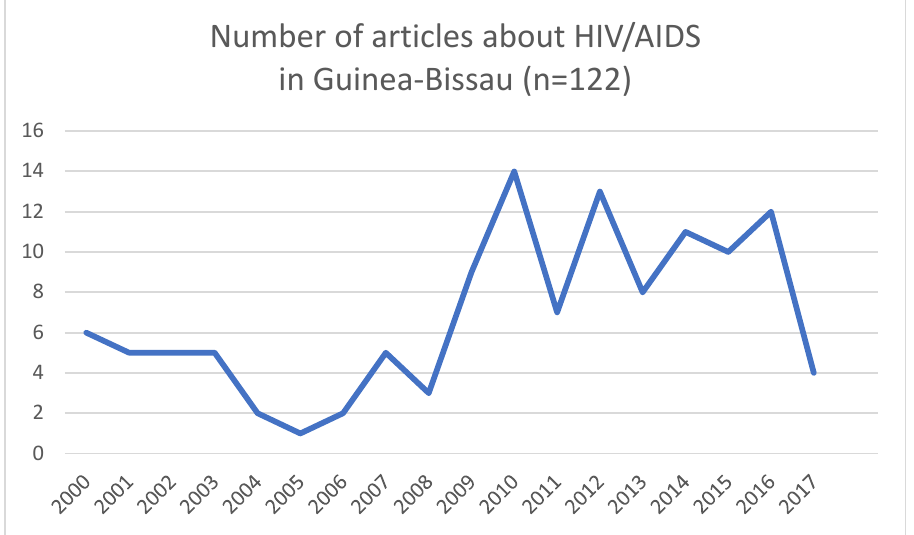
Figure 4. Year of publication (n = 122).